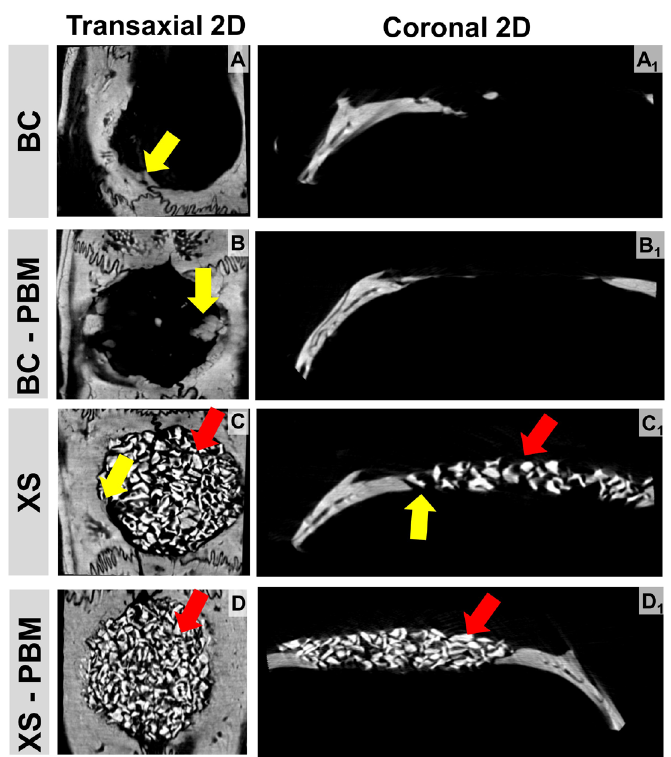
Figure 4. Two-dimensional microtomographic images, (A-D) transaxial and (A1-D1) coronal sections, which demonstrate the repair of critical defects in calvaria, treated with clot (BC and BC-PBM) and biocomplex composed of Bio-Oss TM + fibrin biopolymer (XS and XS-PBM) within 42 days. Particles of the biomaterial (red arrow), thin trabeculae and newly formed bone tissue (yellow arrow).